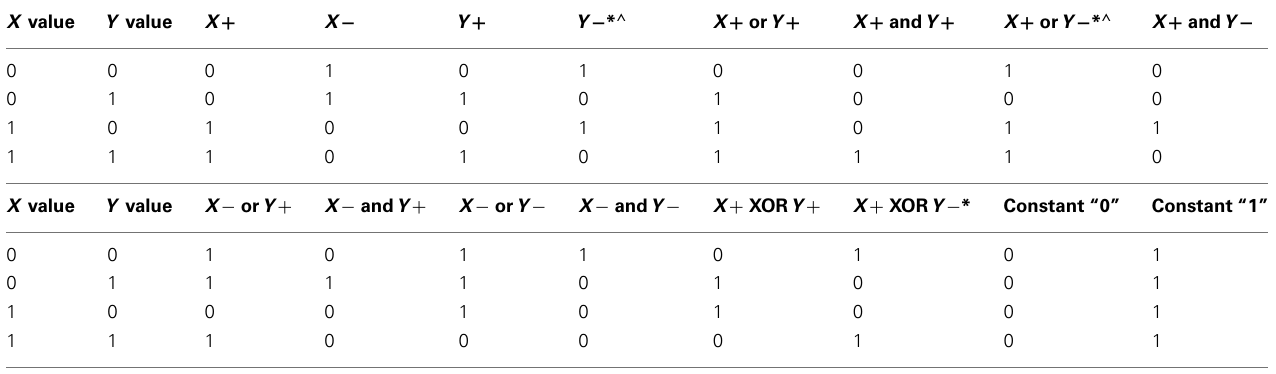
Table 4 | Logical rules for Z .